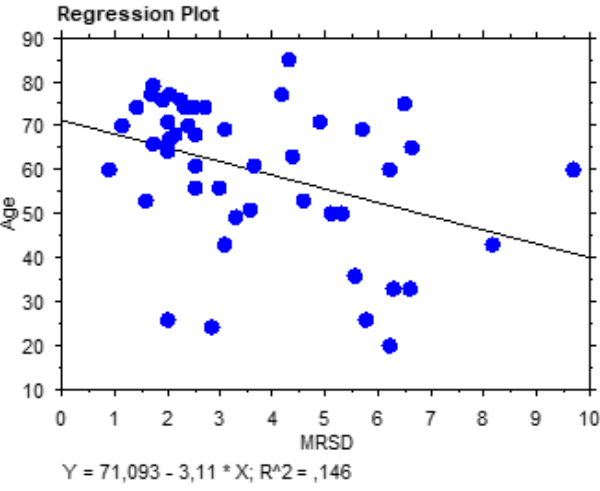
Fig. 5 – Regression plot showing a significant correlation between maximal rate of systolic distension (MRSD) and the patients’